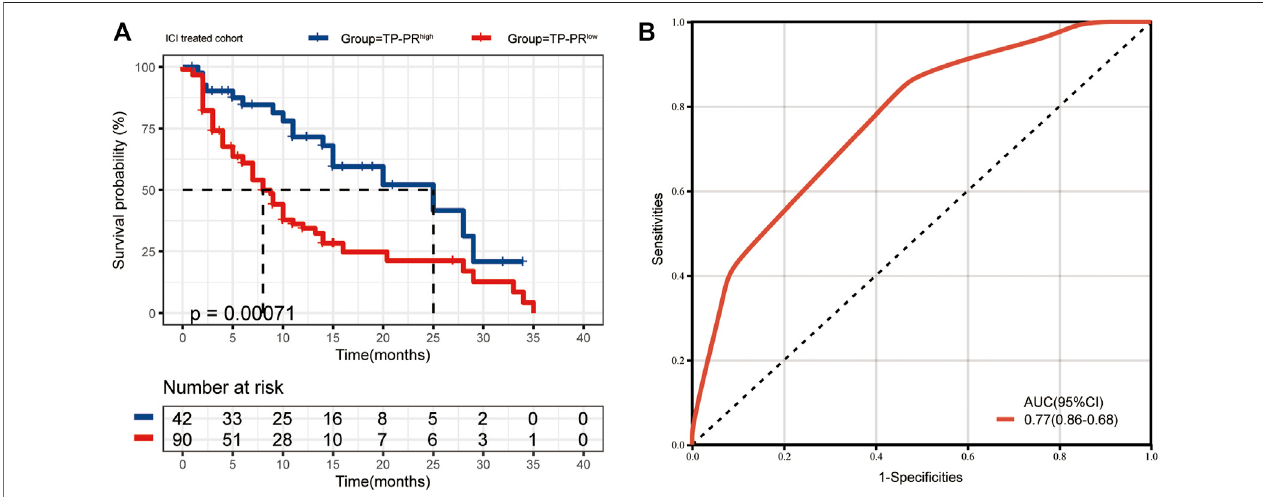
FIGURE 5 | (A) The median OS of ICI-treated r/m HNSCC patients with high TP-PR and low TP-PR (25 vs. 8 months, p (cid:1) 0.00071). (B) The ROC curve of TP-PR strati fi cation. OS, overall survival; ICI, immune checkpoint inhibitor; r/m HNSCC, recurrent and metastatic head and neck squamous cell carcinoma; ROC, receiver operating